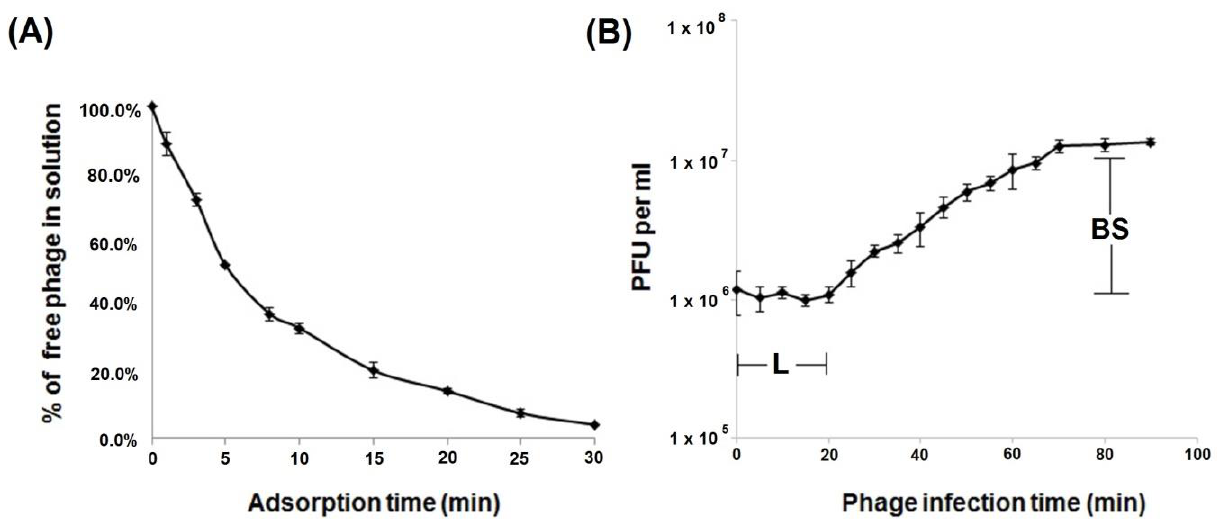
Figure 2. Infection analysis of phage Aristophanes. Adsorption assay ( A ) and one-step growth curve ( B ) of phage Aristophanes on A. baumannii KZ1098 with the indication of estimated latent period (L) and burst size (BS). Results are the means and standard deviations from three independent experiments. PFU: plaque-forming units.